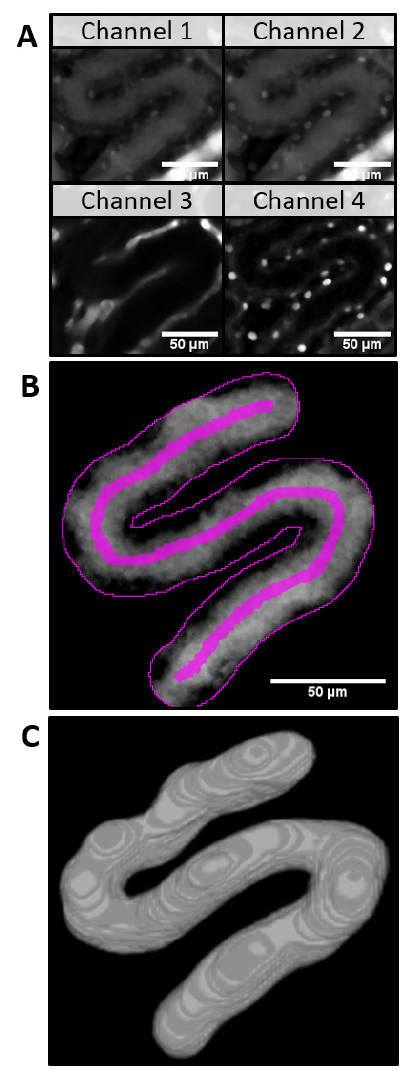
Figure 2. Automatic 3D modelling of tubular volume in a z-stack of the proximal tubule (PT). A ) After applying a 3D median filter, the channel 3 and channel 4 z-stacks were subtracted from channel 2 to eliminate spectral bleedthrough artifacts ( B ). The proximal tubule (PT) was segmented with the help of a 3D watershed (3D model of the resulting z-stack, C ).